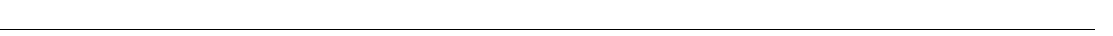
Figure 1 | B-cell receptor (BCR) signalling is a central ‘outside-in’ and ‘inside-out’ signalling hub for MCL cell survival and growth. ( a ) Co-culture with lymph node stromal cells (HK-Ad) and bone marrow stromal cells (HS-5) induced a time-dependent BCR signalling activation detected by western blot for BCR downstream molecules (BTK, AKT, ERK) phosphorylation in MCL cell lines (HBL-2, Jeko-1). ( b ) Co-culture with lymph node stromal cells induced BCR signalling activation detected by western blot for BCR downstream molecules (BTK, AKT, ERK) phosphorylation in primary MCL samples (MCL1–5). ( c ) Co-culture with lymph node stromal cells induced BCR (CD79a) phosphorylation detected by western blot and immunofluorescence staining in HBL-2 cells in co-culture with HK cells. Scale bar, 10 m M. ( d ) Inhibition of BCR signalling using BTK and PI3K d inhibitors (50nM ibrutinib and 100nM GS-1101) attenuated stroma-induced AKT and ERK activation in SP49 and Mino cells. ( e ) Ibrutinib induced cell apoptosis, overcame stroma-mediated drug resistance and enhanced doxorubicin (0.5 m M)-induced apoptosis in Jeko-1, HBL-2, Mino and SP49 cells (Sus, cells in suspension, HK-Ad, cells in co-culture with HK cells). * P o 0.05 and ** P 4 0.05 (Student’s t -test). ( f ) Ibrutinib inhibited clonogenic growth with and without stroma co-culture. ( g